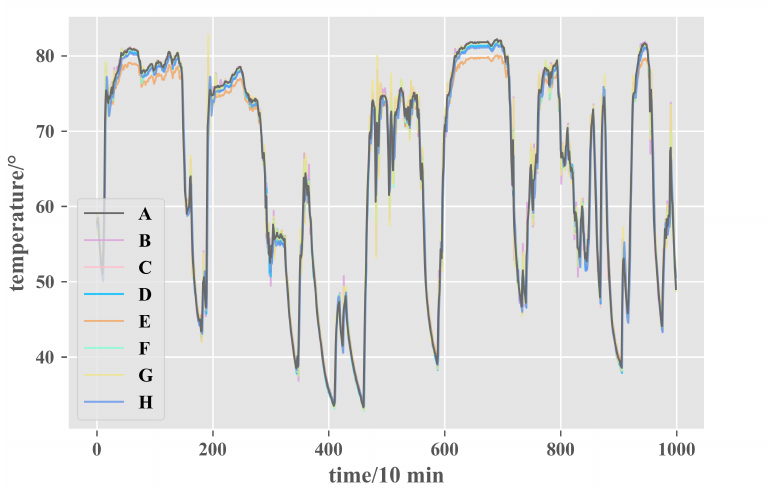
Figure 14. The comparison of different models for gearbox output shaft temperature prediction in